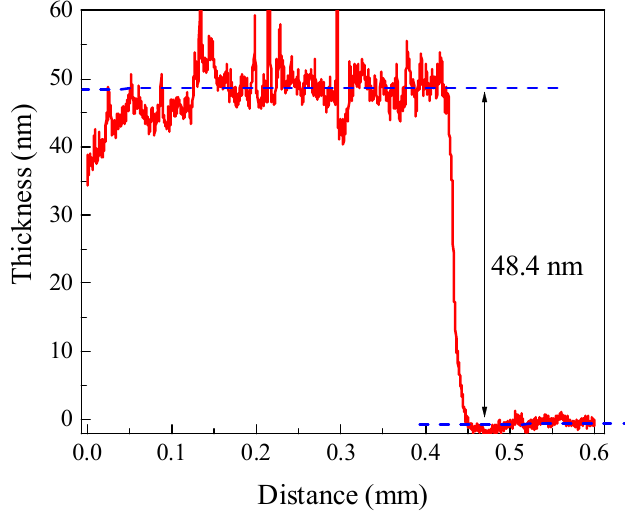
Figure 1. Thickness measured by profilometry of one of the deposited films.